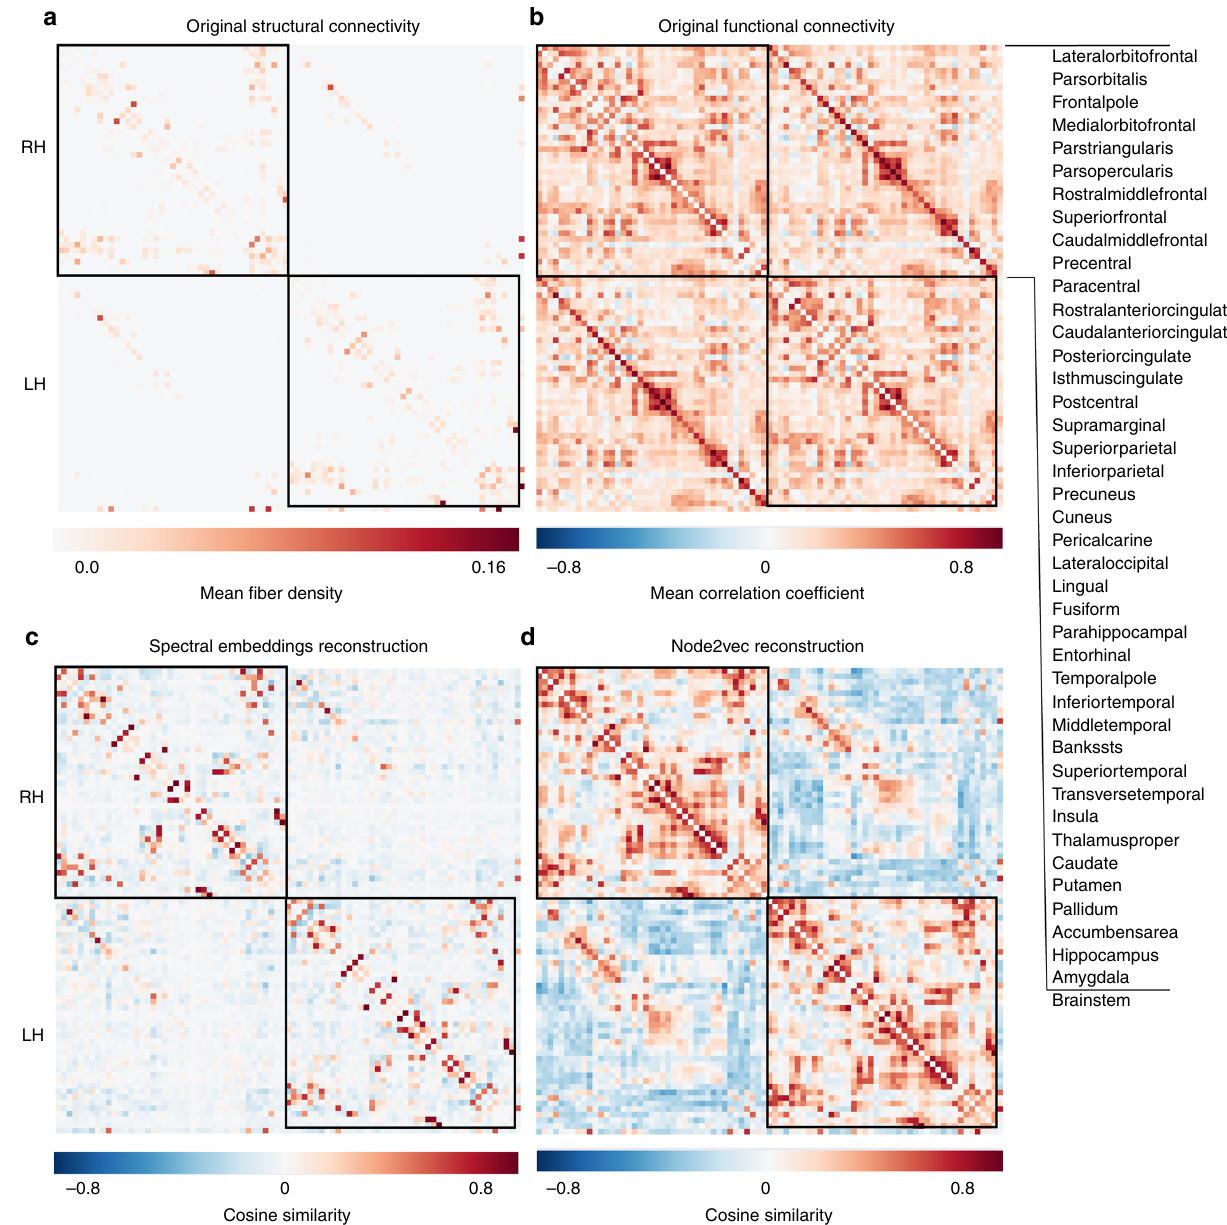
Fig. 3 Cosine similarity of the structural connectivity matrix and node embeddings. a The original structural connectivity matrix with 83 prede fi ned regions of interest (see Cammoun et al., 2012). Each cell represents a structural connection between a pair of regions. The same regions are used in all matrices. b The original mean functional connectivity. c Cosine similarity between spectral embeddings. See text for a statistical analysis. d Cosine similarity